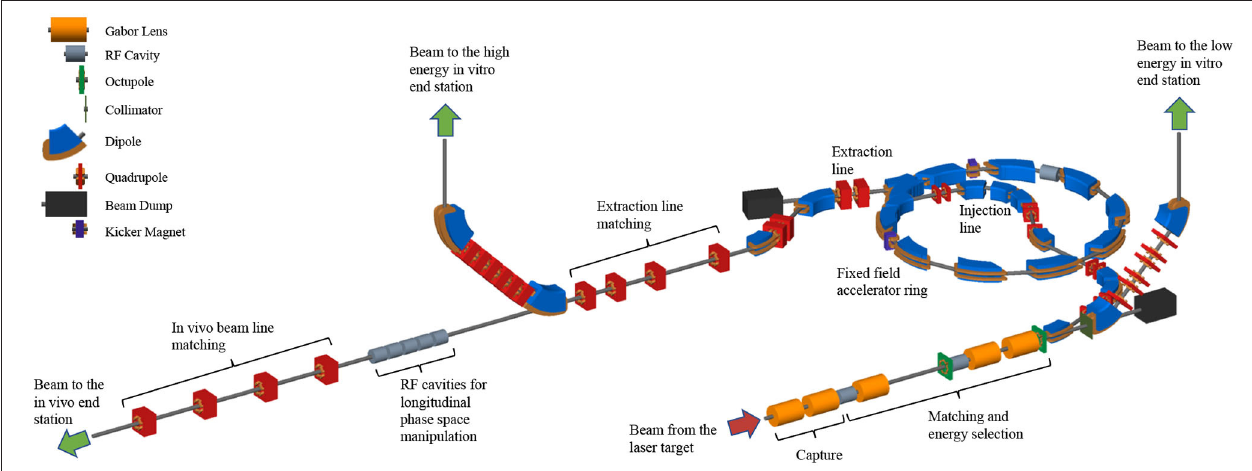
FIGURE 1 | Schematic diagram of the LhARA beam lines. The particle flux from the laser-driven source is shown by the red arrow. The “Capture” section is followed by the “Matching and energy selection” sections, the beam is directed either into the 90 ◦ bend that takes it to the low-energy in vitro end station, toward the FFA injection line, or to the low-energy beam dump. Post-acceleration is performed using the FFA, on extraction from which the beam is directed either to the high-energy in vitro end station, the in vivo end station, or the high-energy beam dump. Gabor lenses are shown as orange cylinders, RF cavities as gray cylinders, octupole magnets as green discs, collimators as dark-green bars, dipole magnets are shown in blue, quadrupole magnets are shown in red, beam dumps (black rectangles) and kicker magnets are also